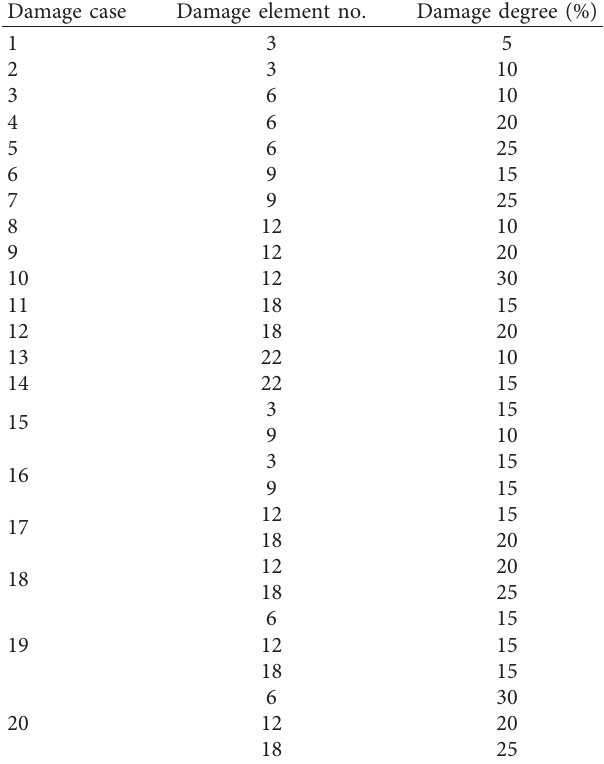
Table 1: Damage cases of simply supported beam. Damage case Damage element no.